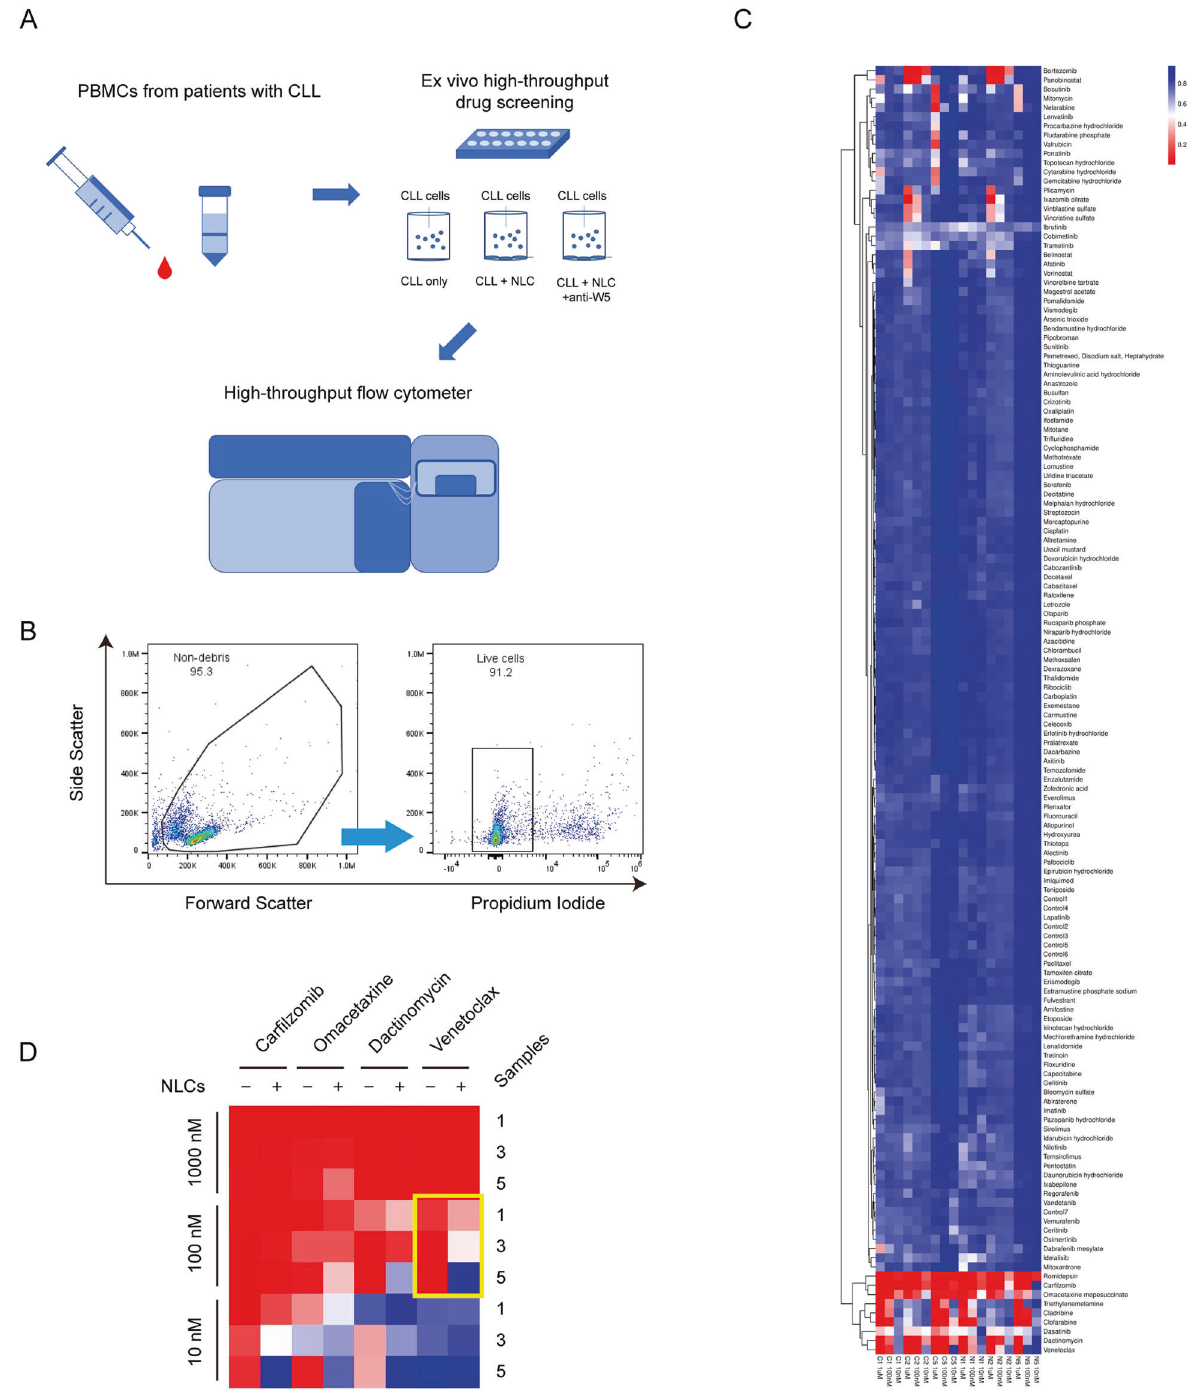
Fig. 4 Wnt5a is involved in NLCs-induced drug-resistance of CLL cells. A The fl ow chart of the high-throughput drug sensitivity analysis. B The gating strategy of live cells in fl ow cytometry. C The heatmap of the high-throughput drug sensitivity analysis by using 133 FDA- approved oncology drugs. C1, 2, and 5: CLL cells cultured alone as the control group. N1, 2, and 5: CLL cells cultured with NLCs. D The sensitivity of CLL cells from patients 1, 2, and 5 to dactinomycin, car fi lzomib, omacetaxine mepesuccinate, and venetoclax. The yellow box highlights the resistance to venetoclax of CLL cells co-cultured with patients with CLL is produced primarily by NLCs, which reside in by anti-Wnt5a antibody. These data provide novel mechanisms for lymphoid tissues. If so, then Wnt5a present in the plasma of venetoclax resistance and potential therapeutic options over- patients with CLL may extend the protective effects of NLCs coming the resistance. beyond the CLL microenvironment in which NLCs reside. Previously, we reported that Wnt5a presents at high levels in Treatment targeting Wnt5a-signaling may mitigate such effects, patients with CLL compared with health donors [21, 40]. We potentially enhancing the clearance of leukemia cells when used speculate that the high-level Wnt5a noted in the plasma of